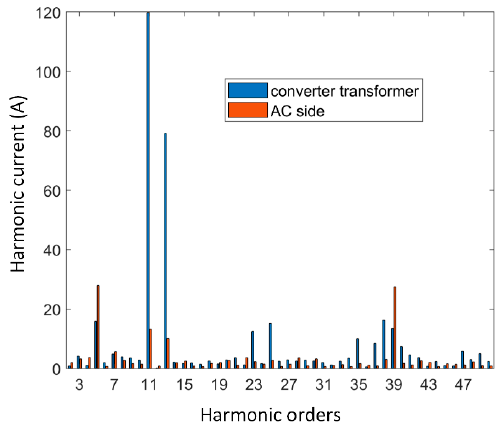
Figure 8. Comparisons of harmonic current components between monitoring points located in converter transformer and AC side.